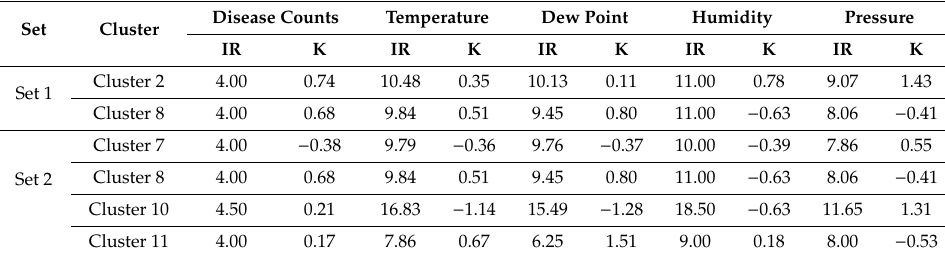
Table 5. Clustering density and homogeneity for selected clusters with high enteritis counts. Disease Counts Temperature Dew Point Humidity Set Cluster Set 1